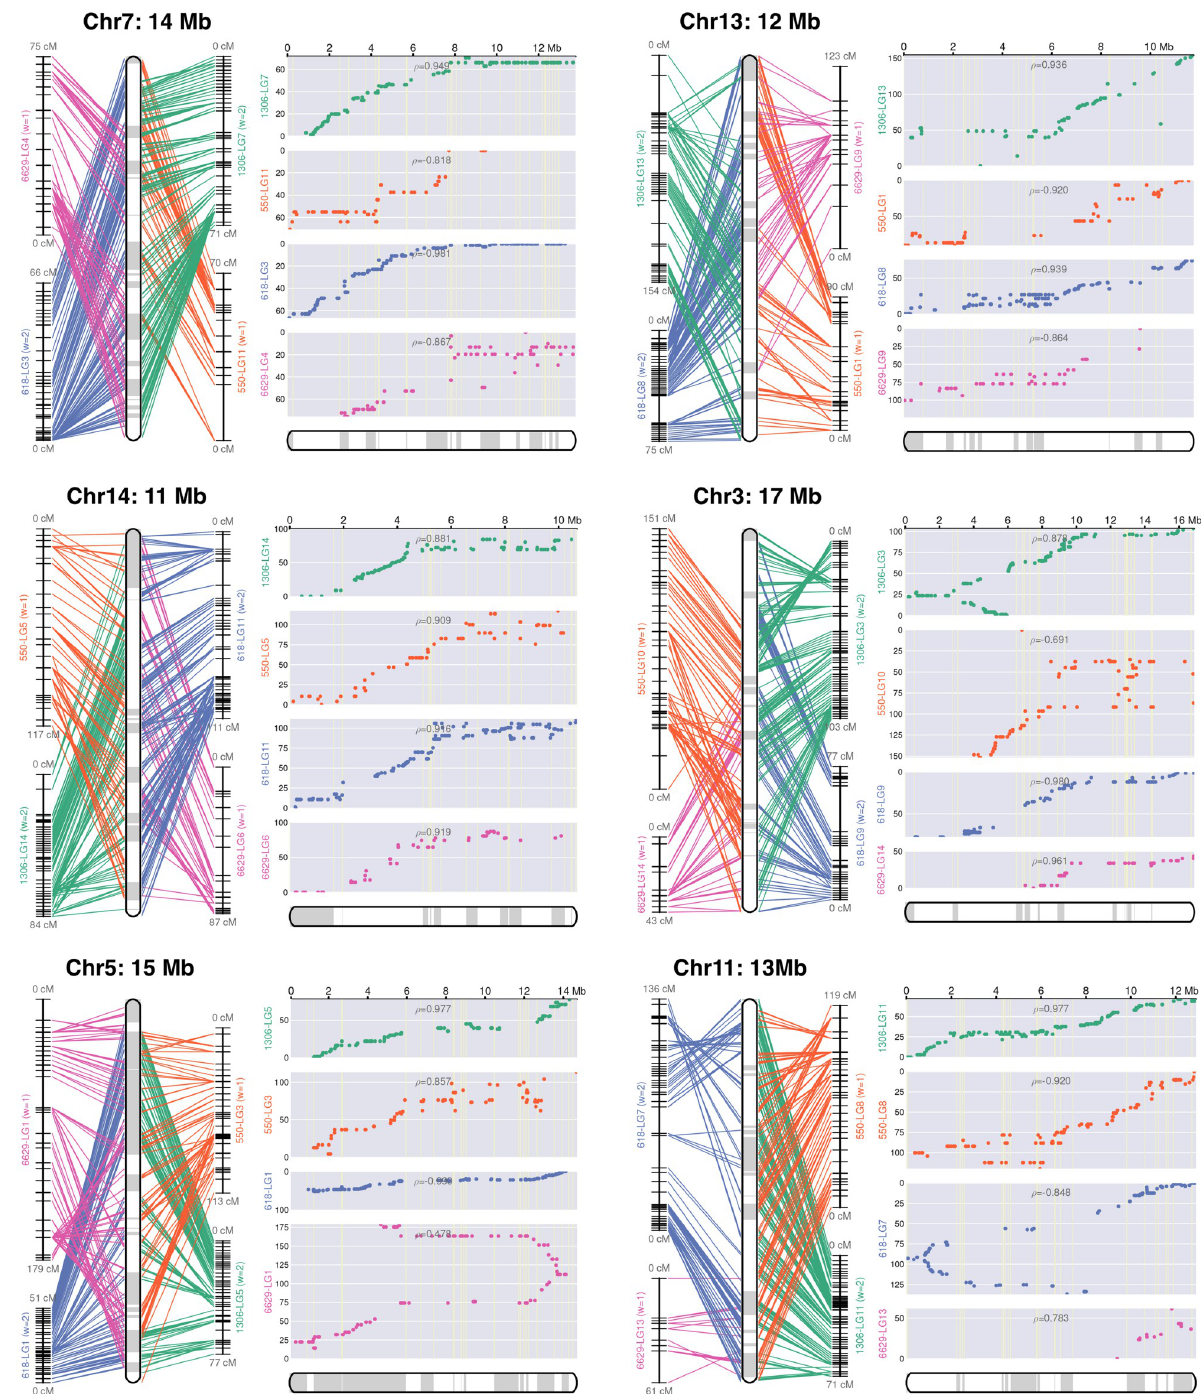
Fig 3. Representative chromosome assemblies. Illustrated are genetic and physical maps for six of the chromosomes; all 15 are presented in S1 Fig. The left panel for each chromosome shows line graphs representing linkage groups (LG) developed for the four parents, with horizontal marks representing loci used for genetic linkage analysis. The rounded rectangles at the center of the panel represent the consensus map for the chromosome, with contigs joined by linkage analysis represented by alternating white and grey sections. The right panels (grey background) show plots of genetic versus physical distance for each chromosome in each parent. The x -axis represents the physical location along the chromosome and the y -axis represents the distance in centimorgans.